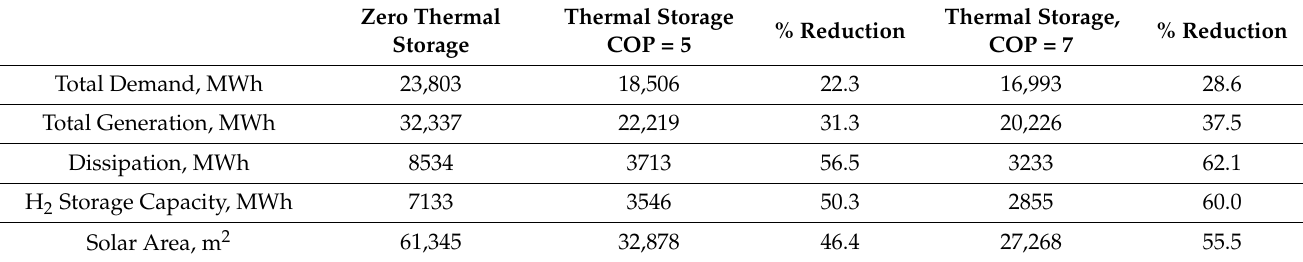
Table 2. The effect of thermal storage on key parameters for the conversion to renewable energy when one wind turbine is employed.